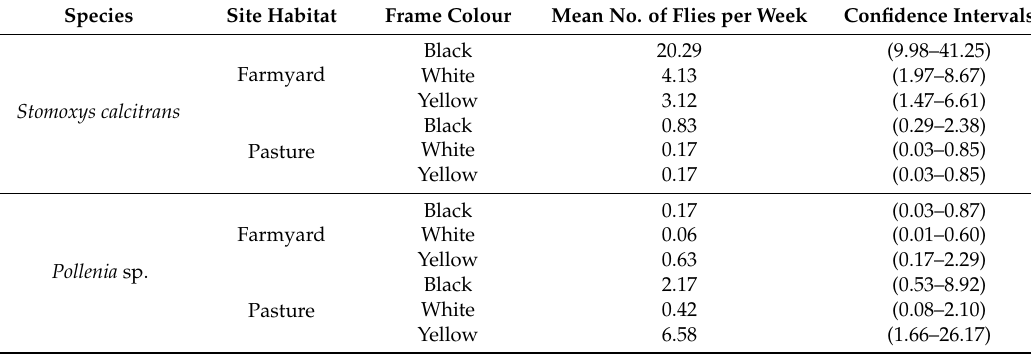
Table 1. Mean numbers of S. calcitrans and Pollenia sp. caught on white sticky traps (225 × 400 mm) surrounded by 100 mm frames of black, white or yellow Corriboard®at a total of five sites, comprising three farmyards and two pasture sites, over six weeks. Means and 95% confidence intervals are back-transformed from the